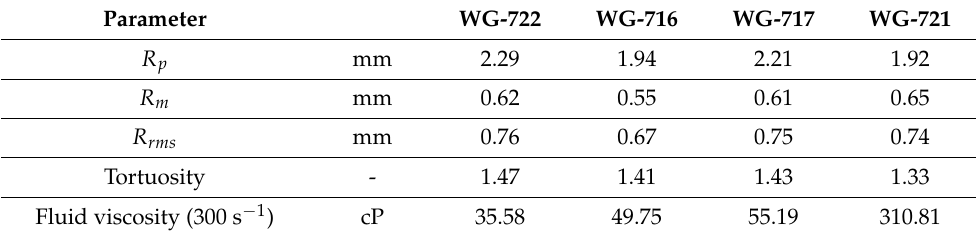
Table 6. Statistical surface roughness parameters of selected samples (Equations (1)–(3)).